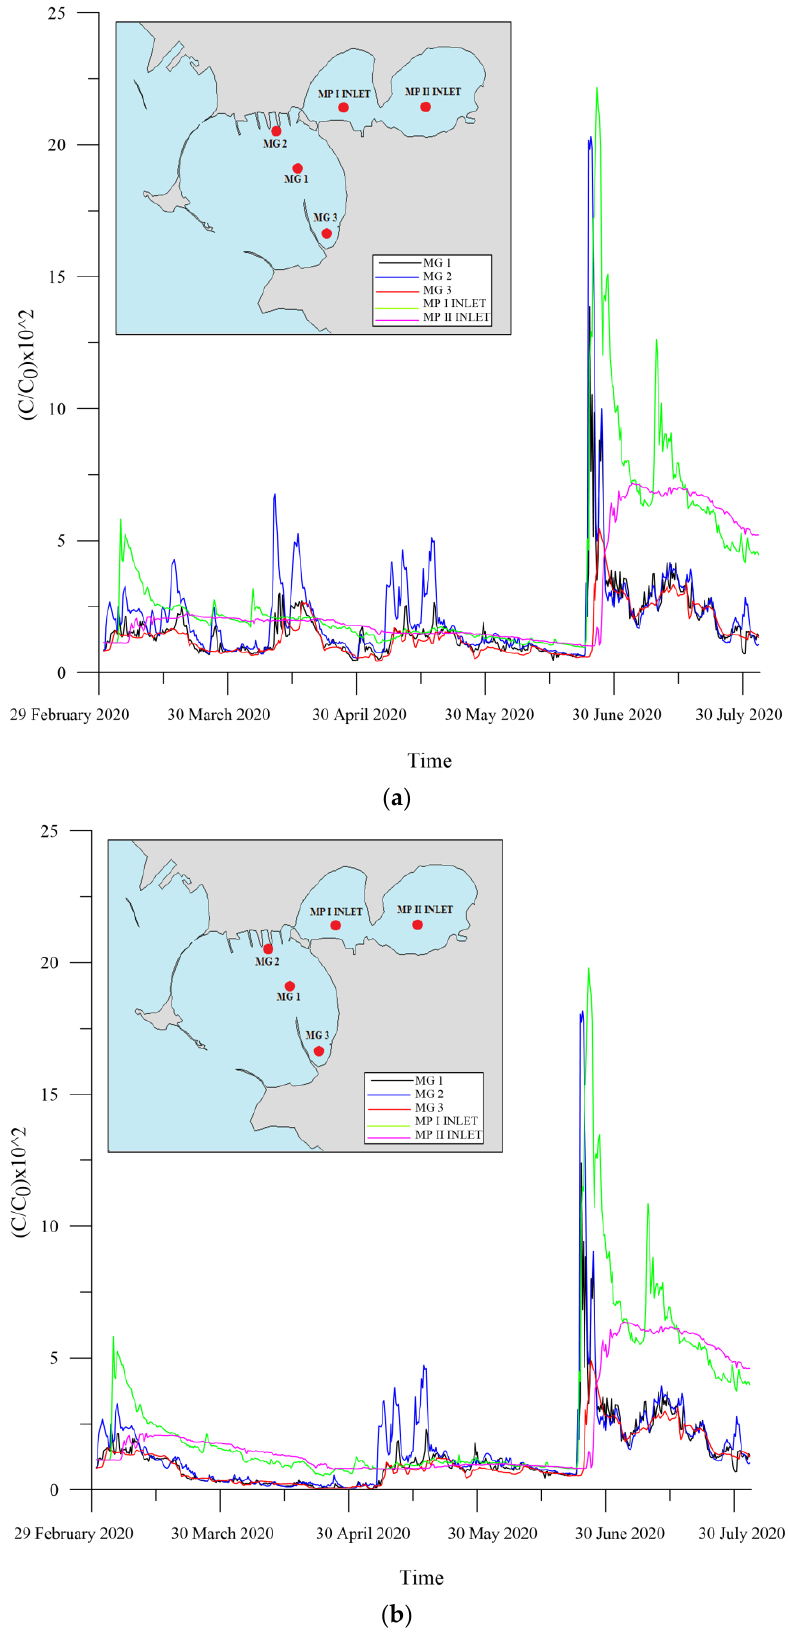
Figure 8. Time series of heavy metal concentrations (IPAs) at stationing points ( a ) AD1; ( b ) AD2.